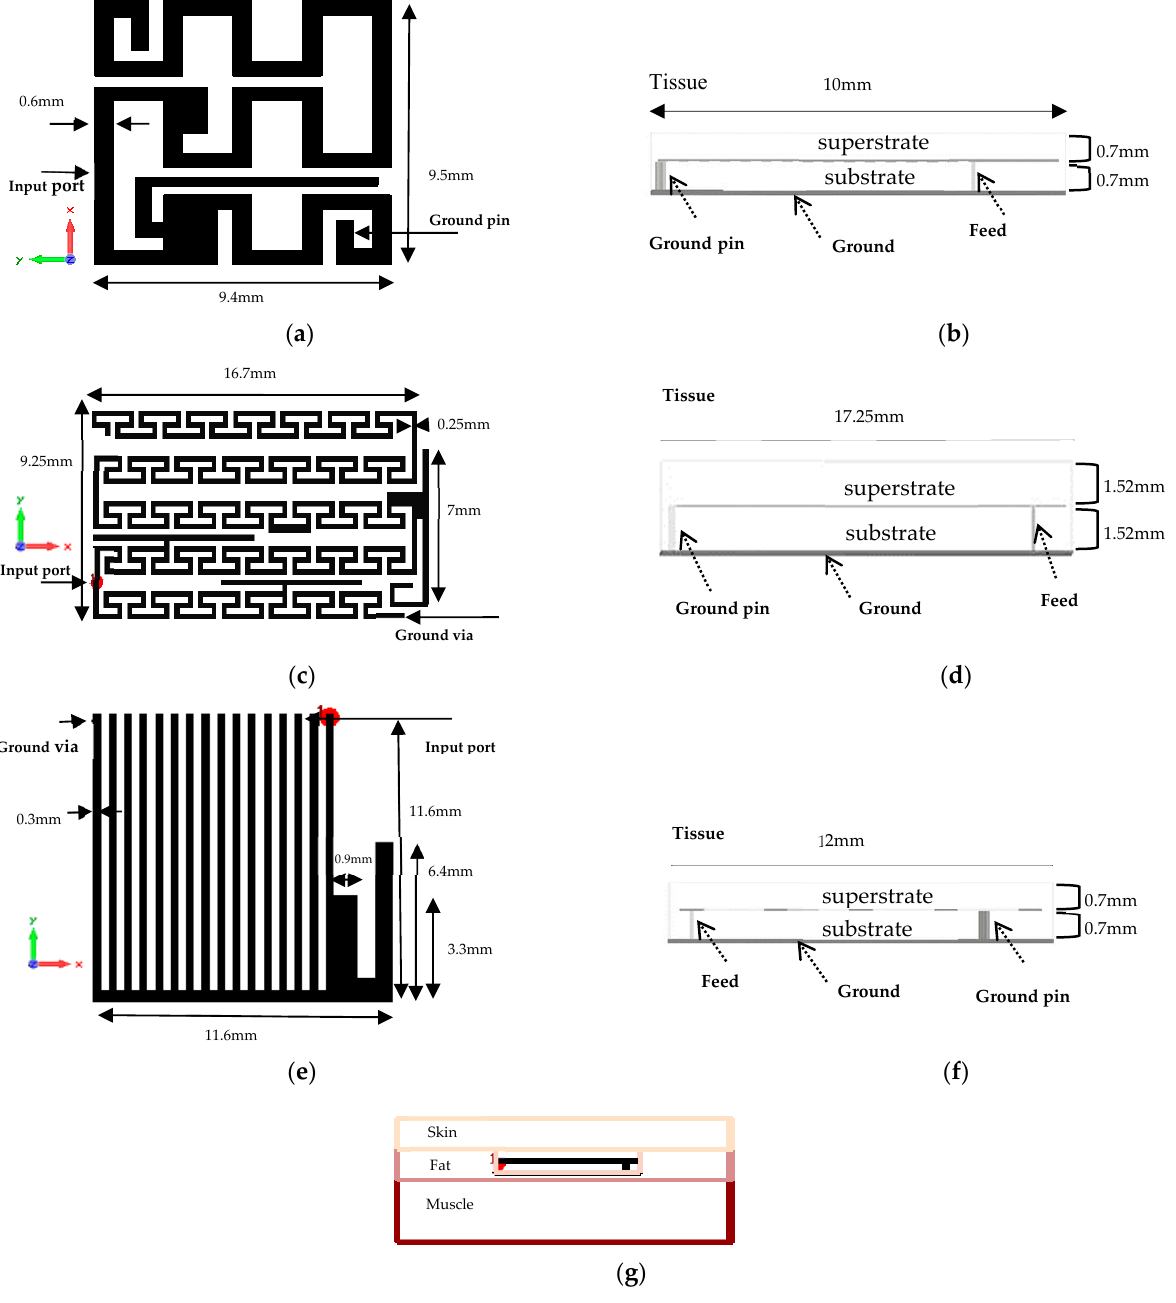
Figure 1. Geometry of Antenna I based on Hilbert design ( a ) top view, ( b ) side view; Antenna II based on the meandered structure ( c ) top view, ( d ) side view; Antenna III based on so called comb structure ( e ) top view, ( f ) side view; and ( g ) Side view of implanted antenna inside multi-layer tissue model.